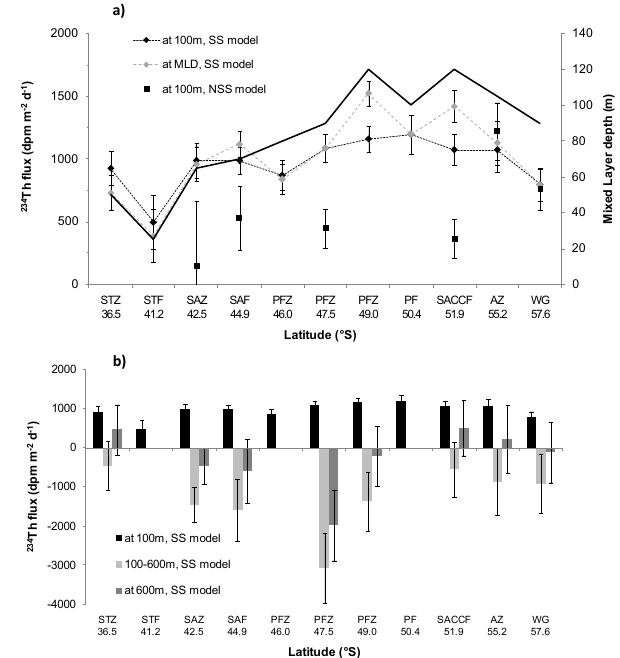
Fig. 4. (a) 234 Th export (dpmm − 2 d − 1 ) at 100m (black diamonds) and at the base of the mixed layer (grey diamonds), calculated us- ing the steady state model; black squares indicate 234 Th export at 100m calculated using the non steady state model; (thick black line = bottom of the mixed layer). (b) 234 Th fluxes (dpmm − 2 d − 1 ) at 100m; between 100 and 600m and at 600m calculated using the steady state